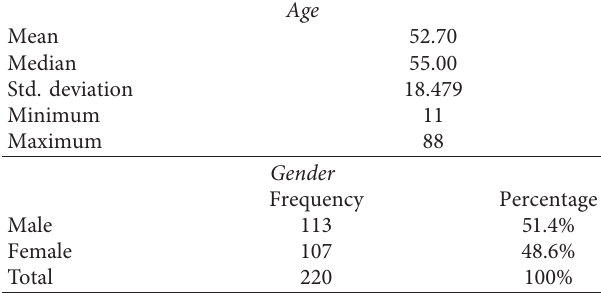
Table 1: The distribution of age and gender among